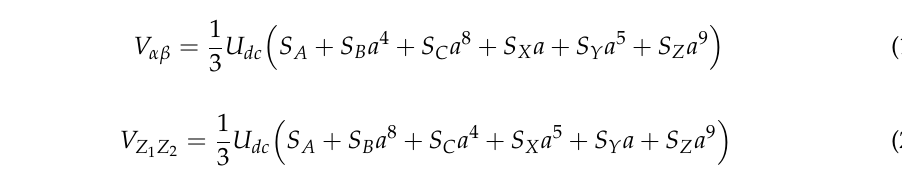
◦ where a = e j 30 , and S K ( K = A, B, C, X, Y, Z) is the switching state of each branch of the inverter. S K = 1 means that the top transistor of leg K is ON and the bottom is OFF. The opposite is true when S K = 0. The corresponding switching states of the six branches constitute a set of binary numbers, which, from high to low, are A, B, C, X, Y and Z. Each set of binary numbers corresponds to an octal number that labels a voltage vector. Therefore, voltage vector diagrams of the α − β subspace and the Z 1 − Z 2 subspace can be obtained, as shown in Figure 2. Each subspace contains 60 effective voltage vectors and 4 zero-voltage vectors. These 60 effective voltage vectors can be classified into four groups according to their amplitudes, i.e., large vector V L , medium vector V M , small vector V S and extra small vector V E . The amplitude of each group of vectors is shown in Table 1. As mentioned previously, the inverter output voltage vector in its natural reference frame can be mapped into three orthogonal planes, namely, the α − β , Z 1 − Z 2 and O 1 − O 2 subspaces, by (3).